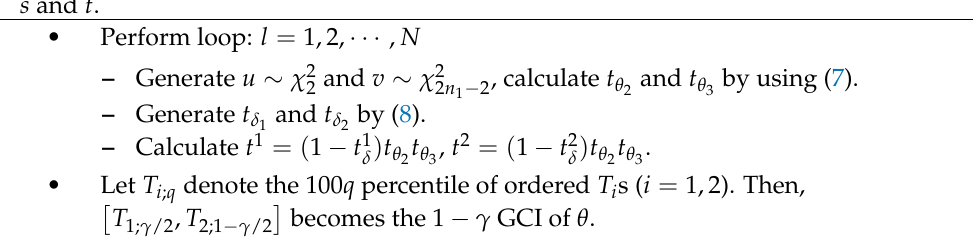
Algorithm 1: For a given sample, determine n 0 and n 1 , and calculate observation s and t